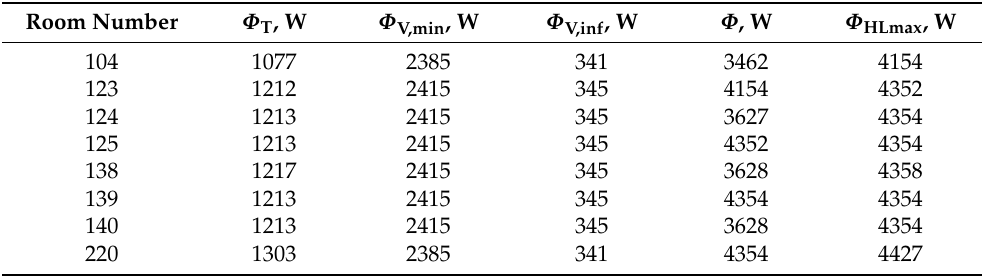
Table 4. Parameters of selected rooms.